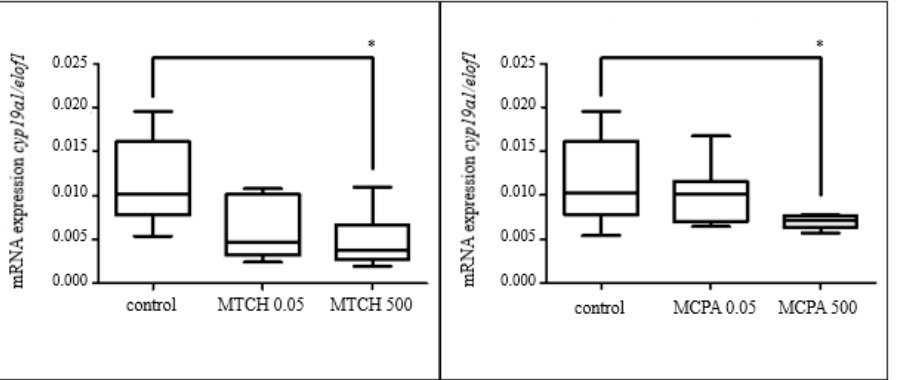
Figure 3. Relative mRNA expression of selected genes in X. tropicalis embryos exposed to various pesticides. Concentrations are indicated in µg/L. Box plot graphs were constructed using median, Q1, and Q2 with whiskers of a maximum 1.5 interquartile range. Statistically significant differences are indicated by * ( p < 0.05).